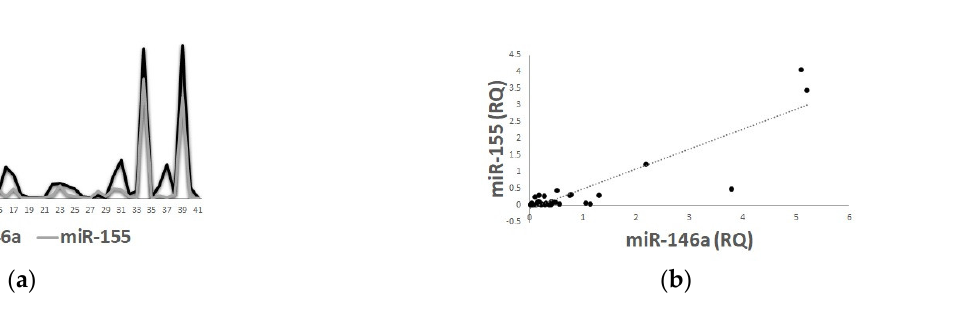
Figure 3. Positive correlation between plasma levels of miR-146a and miR-155 in the patients’ cohort, scatter plot ( a ) and line of tension ( b ).